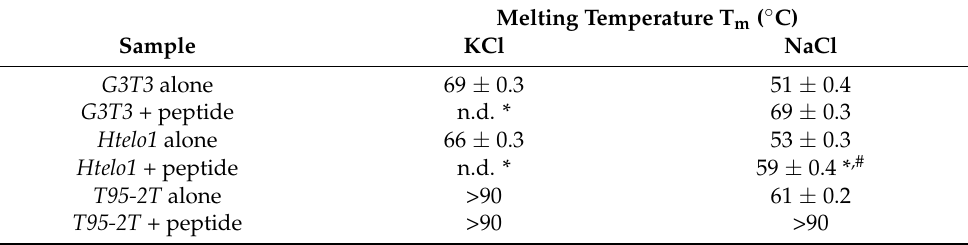
Figure 8. ( A ) SRCD spectra of Htelo1 (13.5 μM) in 10 mM Tris-HCl buffer, pH 7.4, containing 70 mM potassium ions during the annealing process from 10 °C to 90 °C every 5 °C. The dashed line represents the oligonucleotide cooled to 20 °C after heating to 90 °C. The arrows represent the direction of the spectral change as the temperature increased. ( B ) SRCD-melting curves at 206 nm (blue), 271 nm (black) and 286 nm (red), respectively. Insert: Comparison of the corresponding first derivative of the SRCD as a function of temperature. Table 2. Melting temperature values for the G-quadruplex sequences with and without the Rhau25